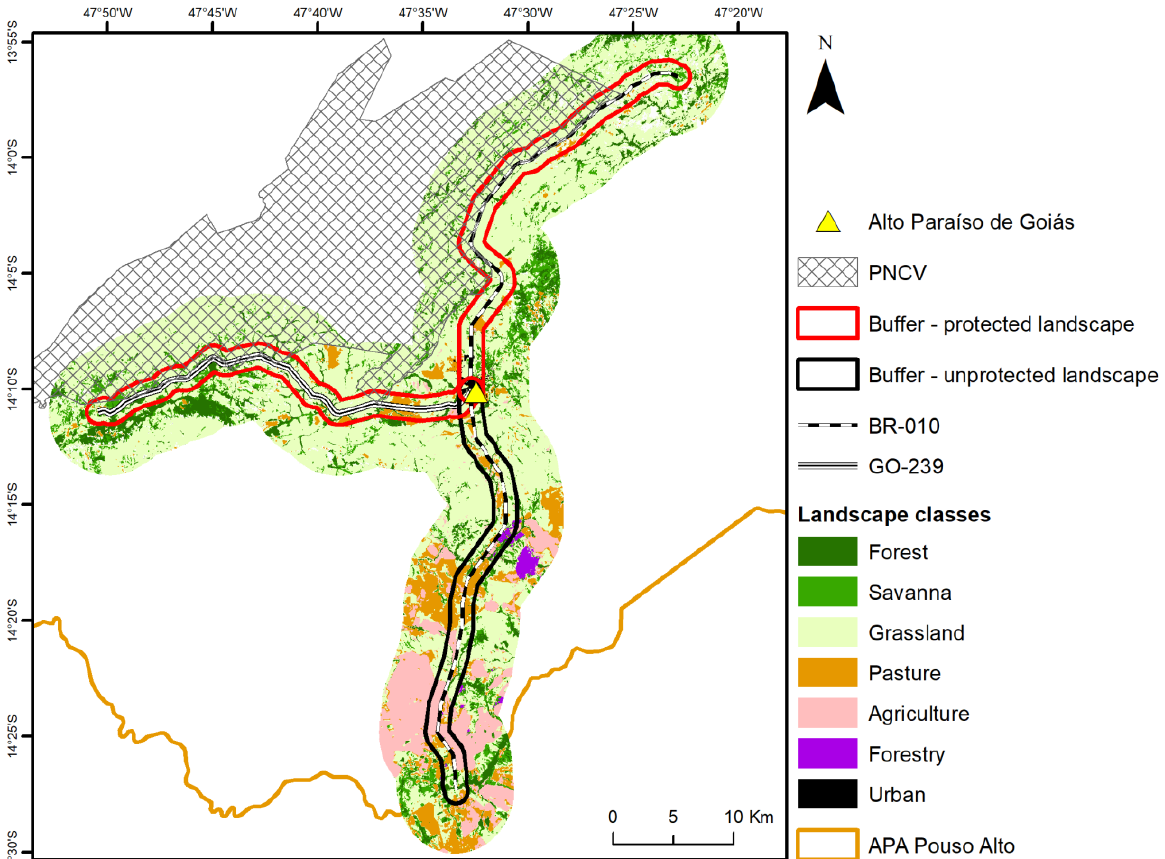
Figure 2. Land use classes around each monitored road stretches in the Pouso Alto APA, which were subsequently related to roadkill patterns. The ‘unprotected landscape’ stretch (BR-010) was the road within the black buffer, where most anthropogenic land uses are found, and the ‘protected landscape’ stretch (BR-010 and GO-239) was the one within the red buffer, bordering the limits of the Chapada dos Veadeiros National Park (PNCV). The PNCV limits were updated in June 5,